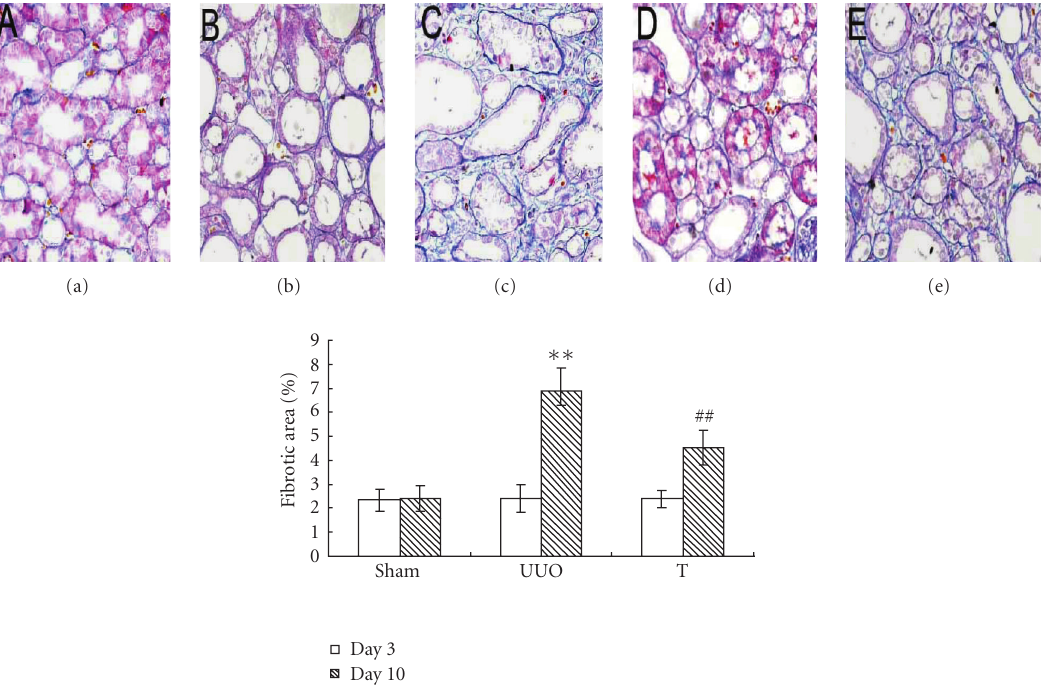
Figure 3: Tubulointerstitial fibrosis at di ff erent time points in three groups ( × 200). Sections were stained with Masson trichrom identifying collagen fibers. Collagen deposition was determined by the point-counting method: (a) sham group, (b) UUO on day 3, (c) UUO on day 10, (d) treatment group on day 3, and (e) treatment group on day 10. ∗∗ : P < . 01 versus sham group of the same time point. ##: P < . 01 versus UUO group of the same time